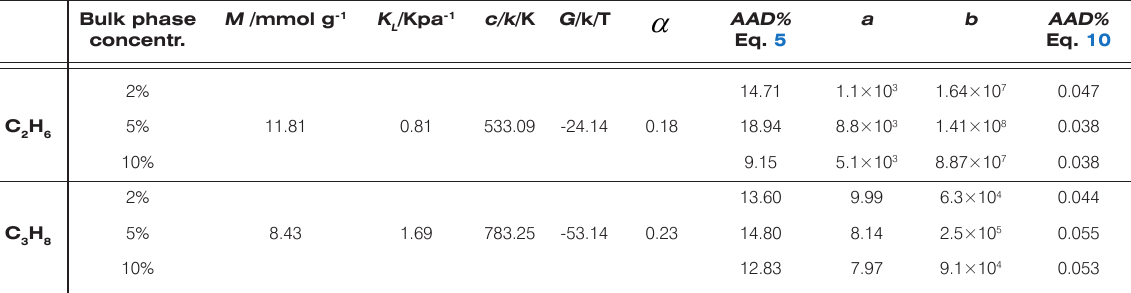
H and C H adsorbed on 2 6 3 8